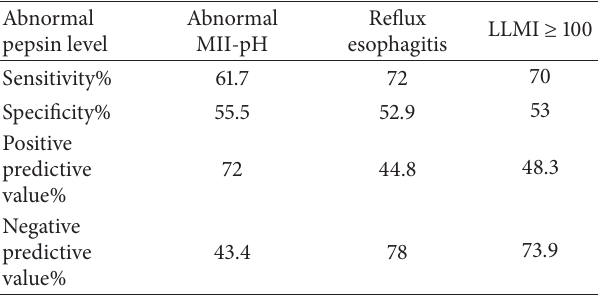
Table 5: Sensitivity and specificity of abnormal BAL pepsin levels to diagnose GERD related infantile wheeze compared to the current standard diagnostic